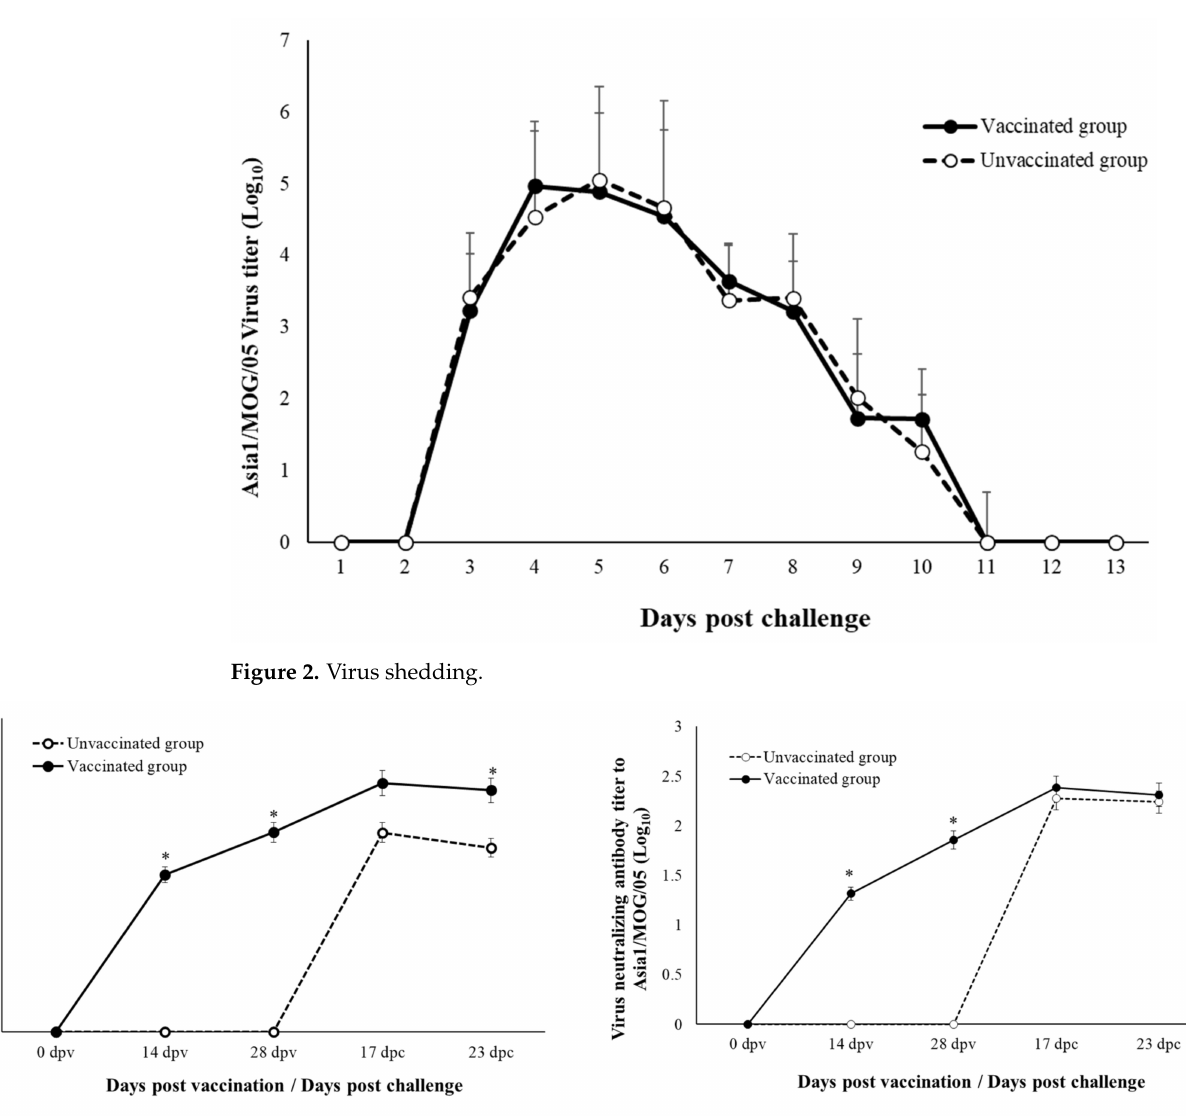
Figure 3. ( A ) VNT to Asia1 Shamir. ( B ) VNT to Asia1_MOG_05. *, statistically significance. p <